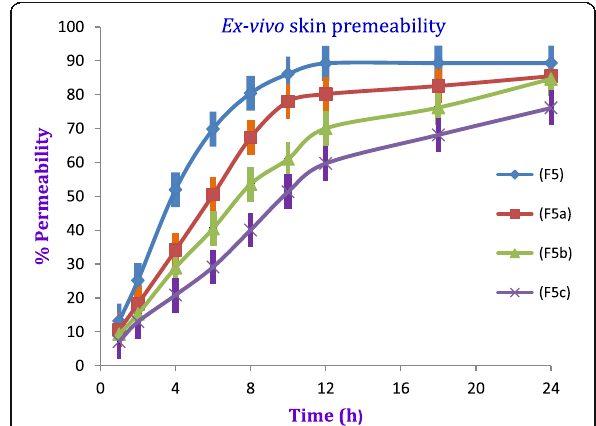
Fig. 6 Ex vivo skin percent permeability for optimized nanoemulsion (F5) and nanoemulgel formulations (F5 a , F5 b , and F5 c